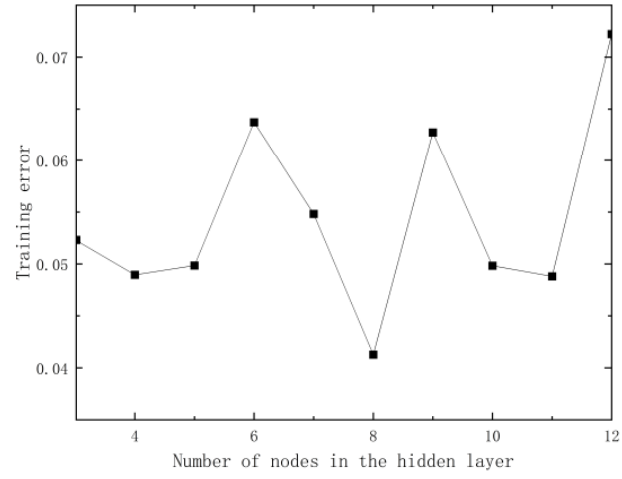
Figure 6. Training error of the different number of nodes in the hidden layer.